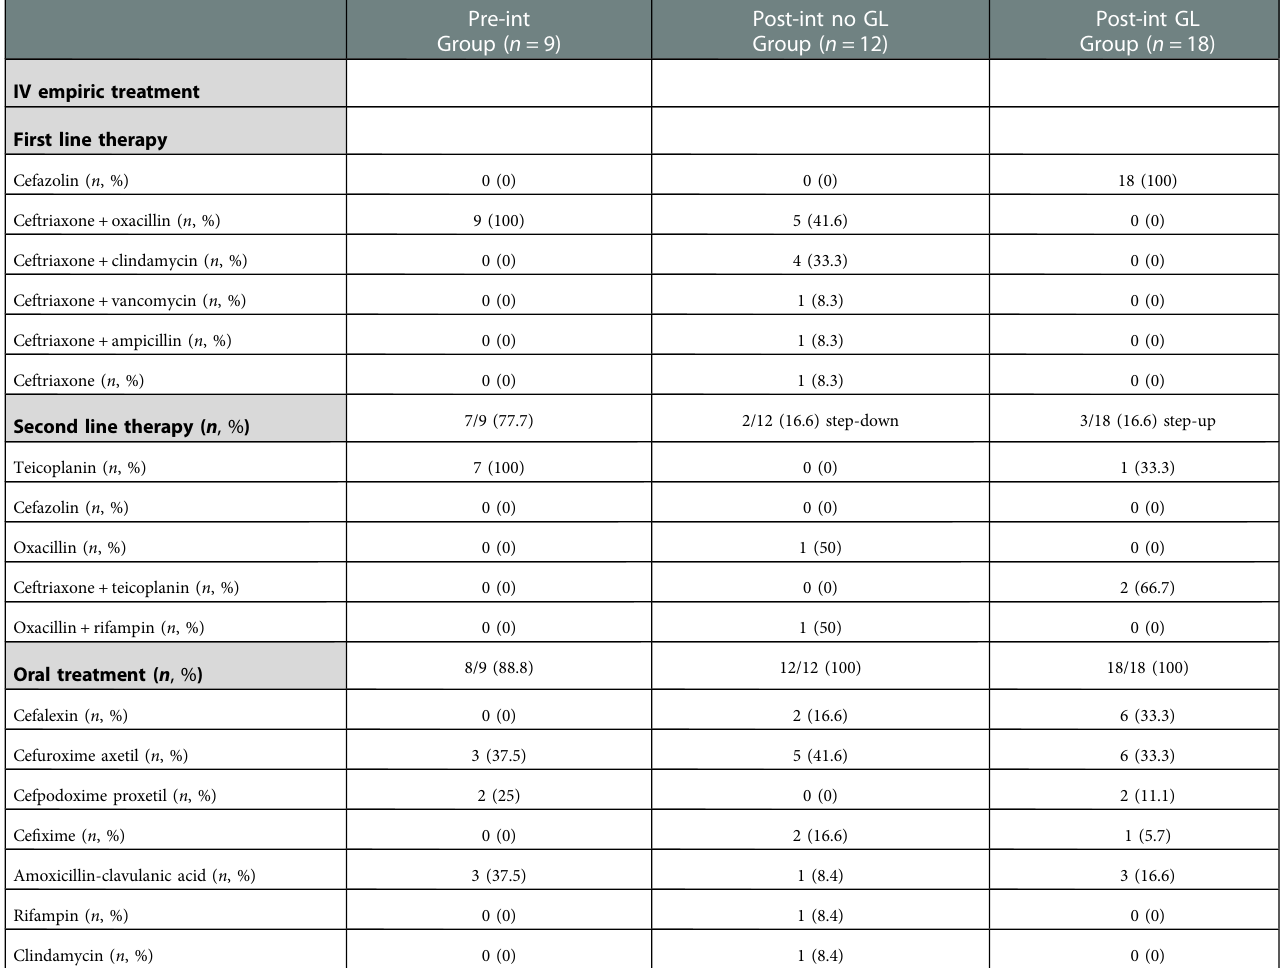
TABLE 7 Antibiotics used in the different groups -